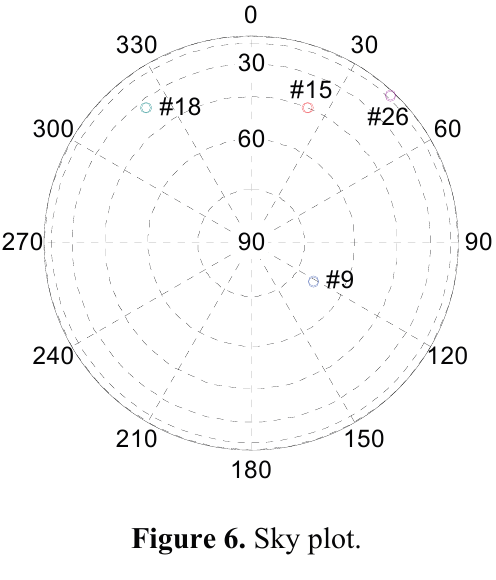
Figure 6. Sky plot.